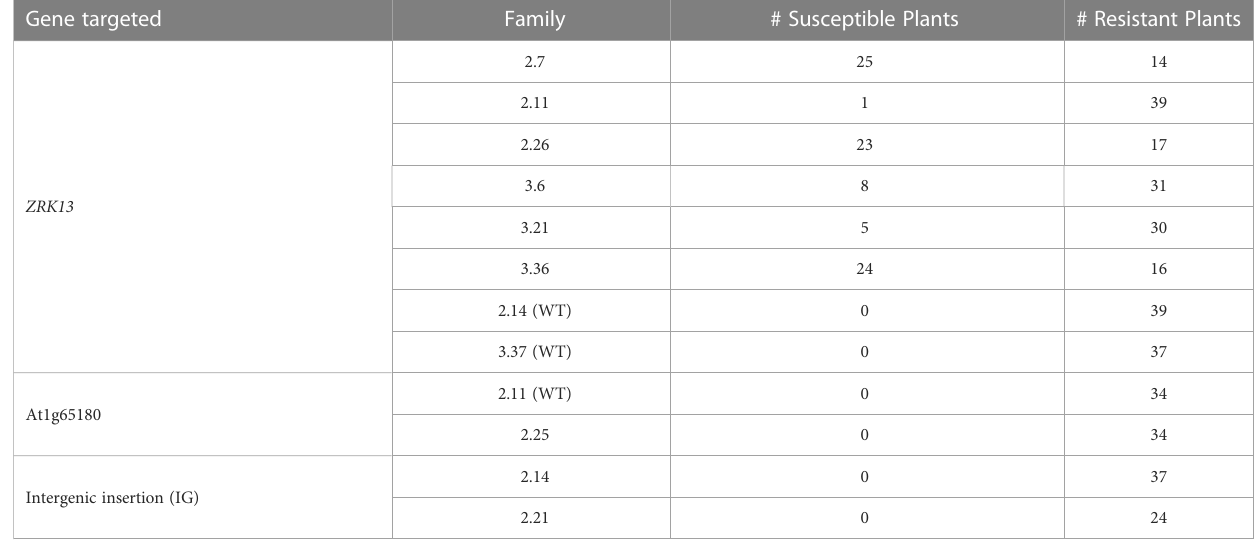
TABLE 1 Phenotype upon inoculation with Pseudoidium neolycopersici ( On ) in the T 2 progeny of the CRISPR/Cas9 transformants. Gene targeted Family # Susceptible Plants # Resistant